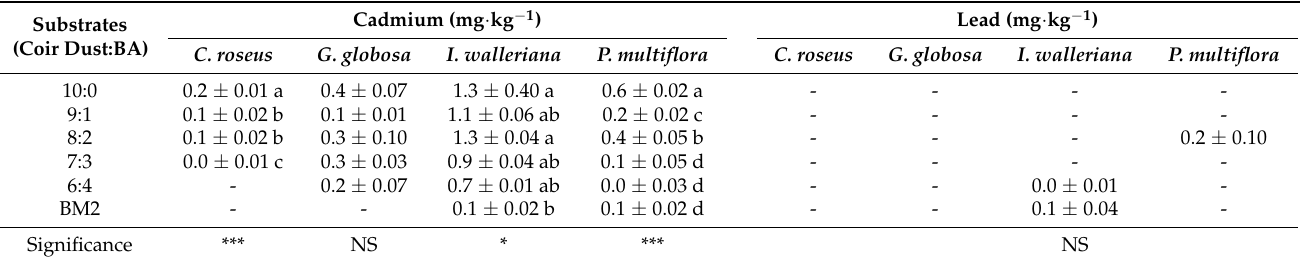
Table 5. The heavy metal contents in four bedding plants ( Catharanthus roseus , Gomphrena globosa , Impatiens walleriana , Petunia multiflora ) seedlings grown for 7 weeks in substrates mixed with coir dust and coal bottom ash (BA) and commercial germinating mixture